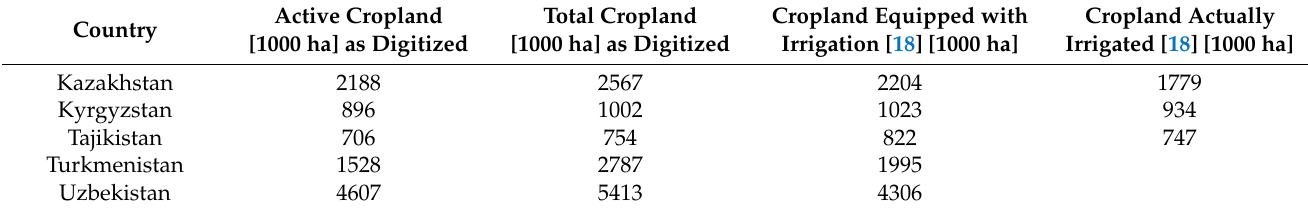
Table 7. Cropland under irrigated agriculture as digitized within this study and irrigated cropland according to